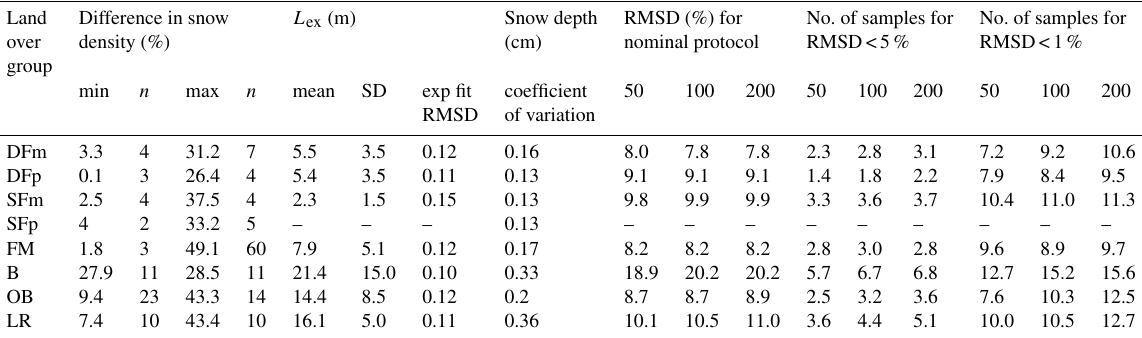
Figure 5. Box plots of measured snow density within each land cover group during the different field measurement days. Measurements from the Saariselkä test site are indicated in bold. Table 4. The minimum and maximum difference during the measurement campaign between a measured density value against an average of other density values representing n number of samples. The mean and standard deviation of exponential autocorrelation length ( L ex ) of snow depth, and RMSD of the exponential fit over the land cover groups, calculated from representative transects during the snow sampling dates between 19 December 2011 and March 23, 2012. An averaged coefficient of variation for snow depth within each land cover group during the measurement campaign. The estimated RMSD of the nominal sampling protocol (as % of “true” snow depth), and the estimated number (threshold) of equally spaced samples required to achieve 5 and 1% RMSD, for scales of 50, 100 and 200m; an average of all acquisition dates by land cover